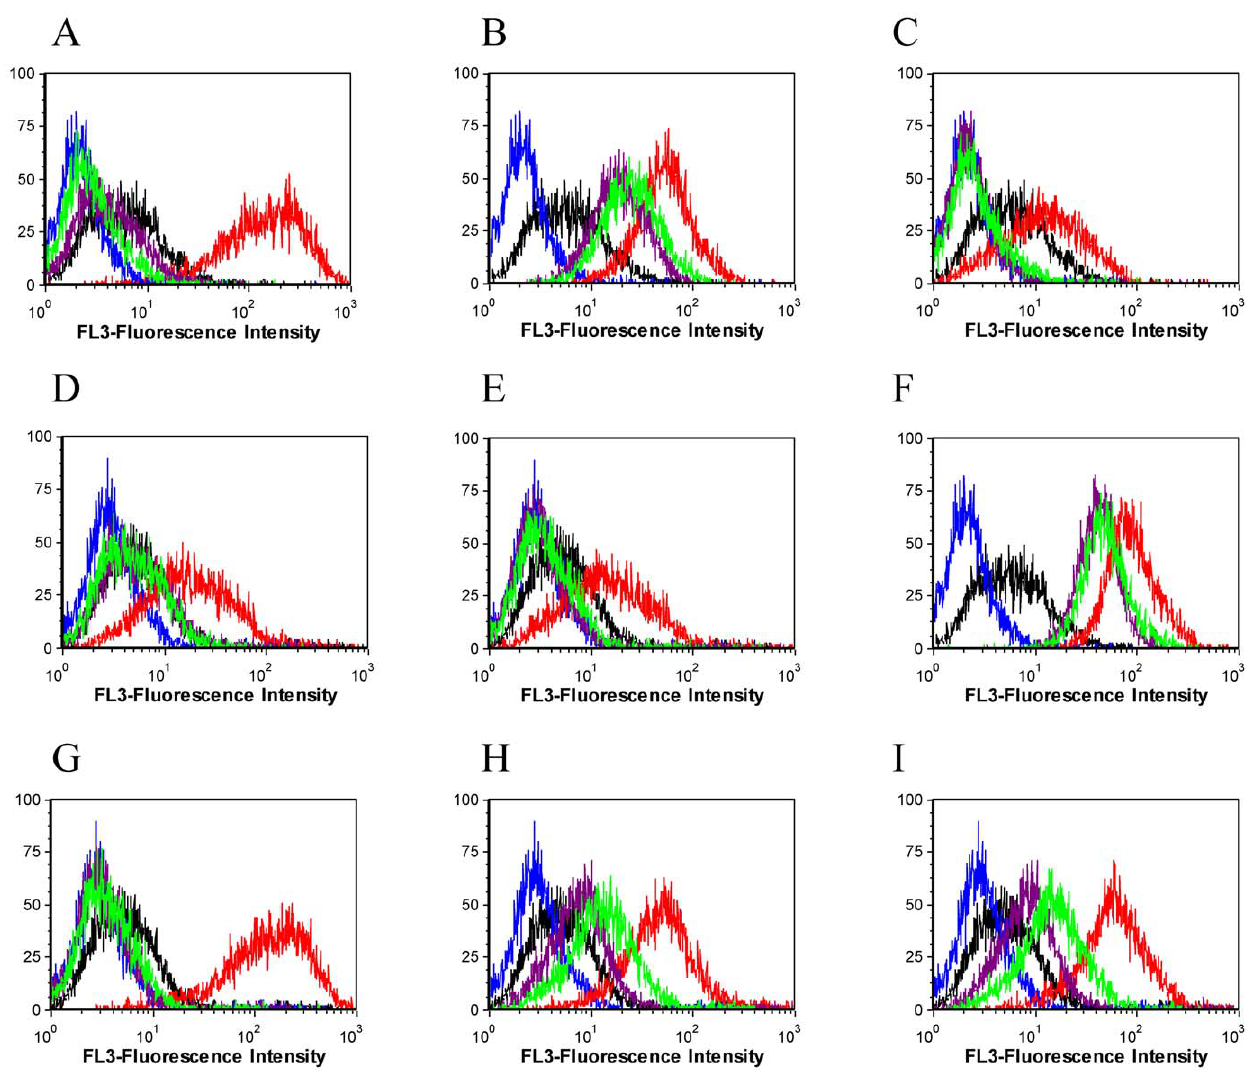
Figure 8. Preliminary determination of cell surface molecule that binds to aptamer. Cells were treated with trypsin and proteinase K for 15 min and then incubated with aptamer. The untreated cell incubated with aptamer was used as positive control. Black histogram, (unselected library with untreated cells); red (aptamer with untreated cells); blue (unselected library with trypsin treated cells); purple (aptamer with trypsin treated cells) and lime (aptamer with proteinase K treated). The following aptamers were assessed; A (KDED2); B (KDED5); C (KDED10); D (KDED18); E (KDED20); F (KCHA10); G (KC2D3); H (KC2D4), I (KC2D8). With the exception of KDED5 and KCHA10 which reduced only minimally, the signal of all others reduced